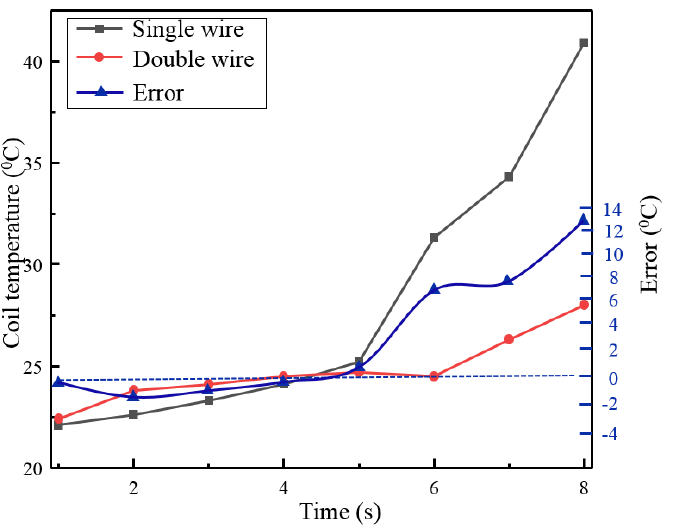
Figure 17. Comparison of temperature rise between single coil and parallel coil.